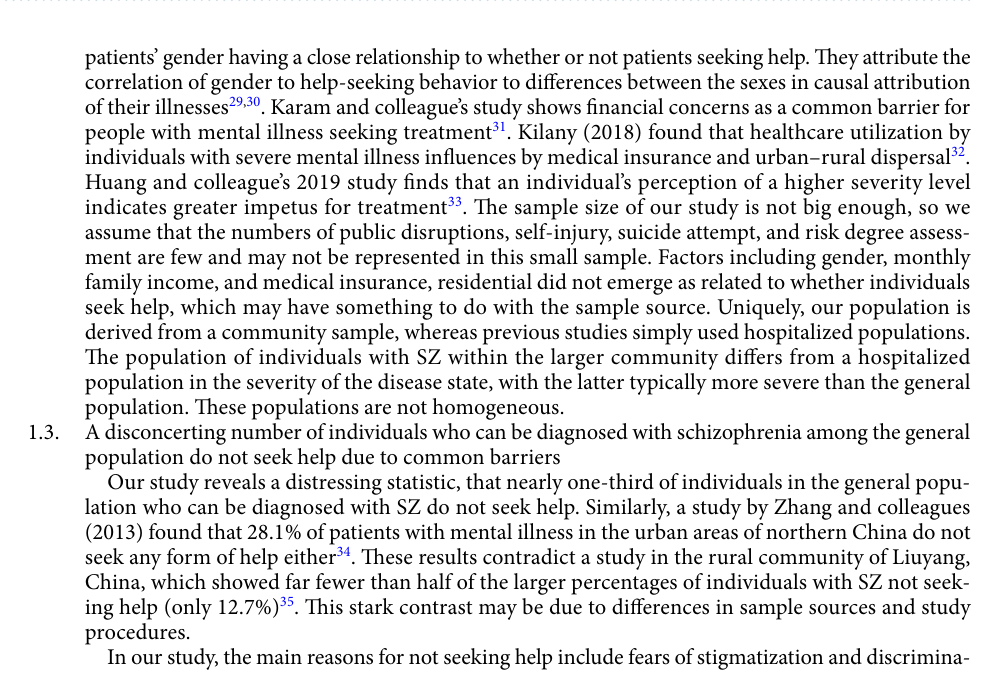
Figure 2. Frequency of the first choice of help for individuals with